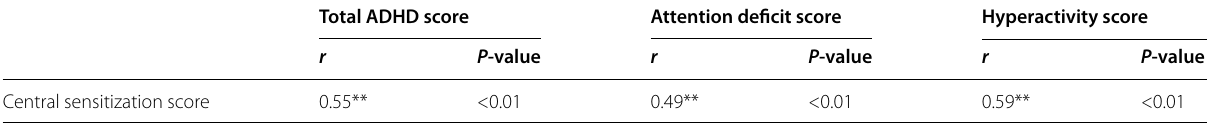
Table 4 Correlation between central sensitization inventory and total attention deficit hyperactivity disorder scores in the studied sample ( n 227) =